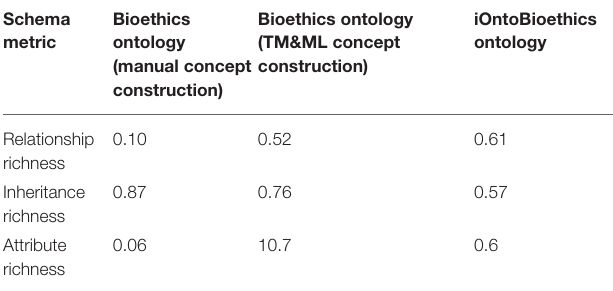
TABLE 3 | Schema metrics